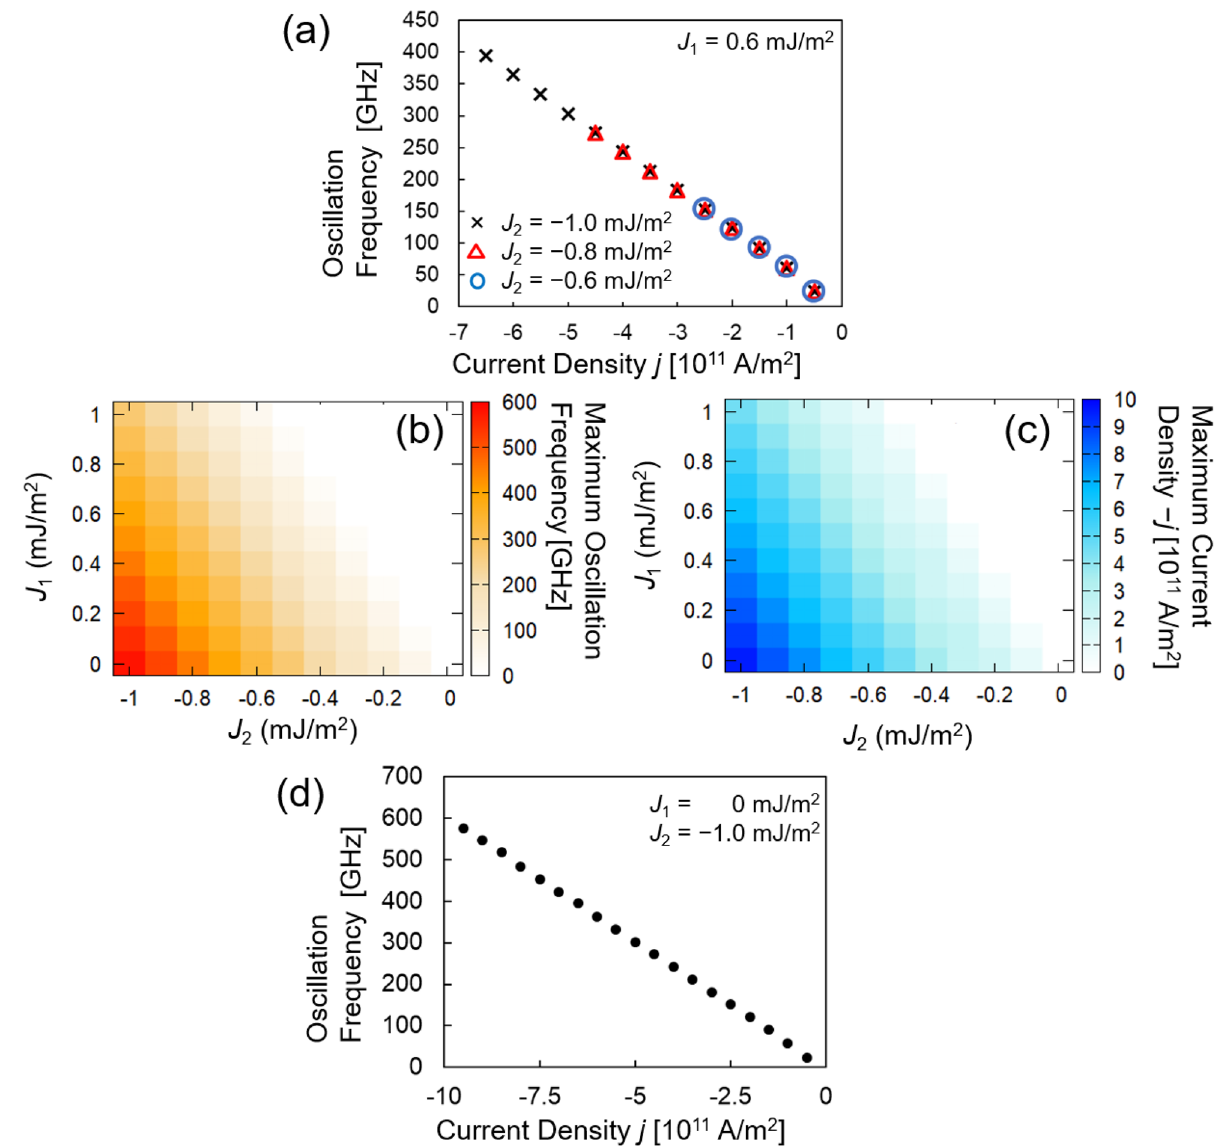
Figure 4. ( a ) Plot of f as function of j for J 2 = −0.6, − 0.8, and − 1.0 mJ/m 2 with J 1 fixed to 0.6 mJ/ m 2 . Dependence of maximum ( b ) f and ( c ) j realizing oscillation on J 1 and J 2 . We determined that the magnetization is in a non-oscillating state when the maximum value of the normalized Fourier spectrum is less than 10 –2 . ( d ) Plot of f as function of j for ( J 1 , J 2 ) = ( 0, − 1.0 ) mJ/m 2